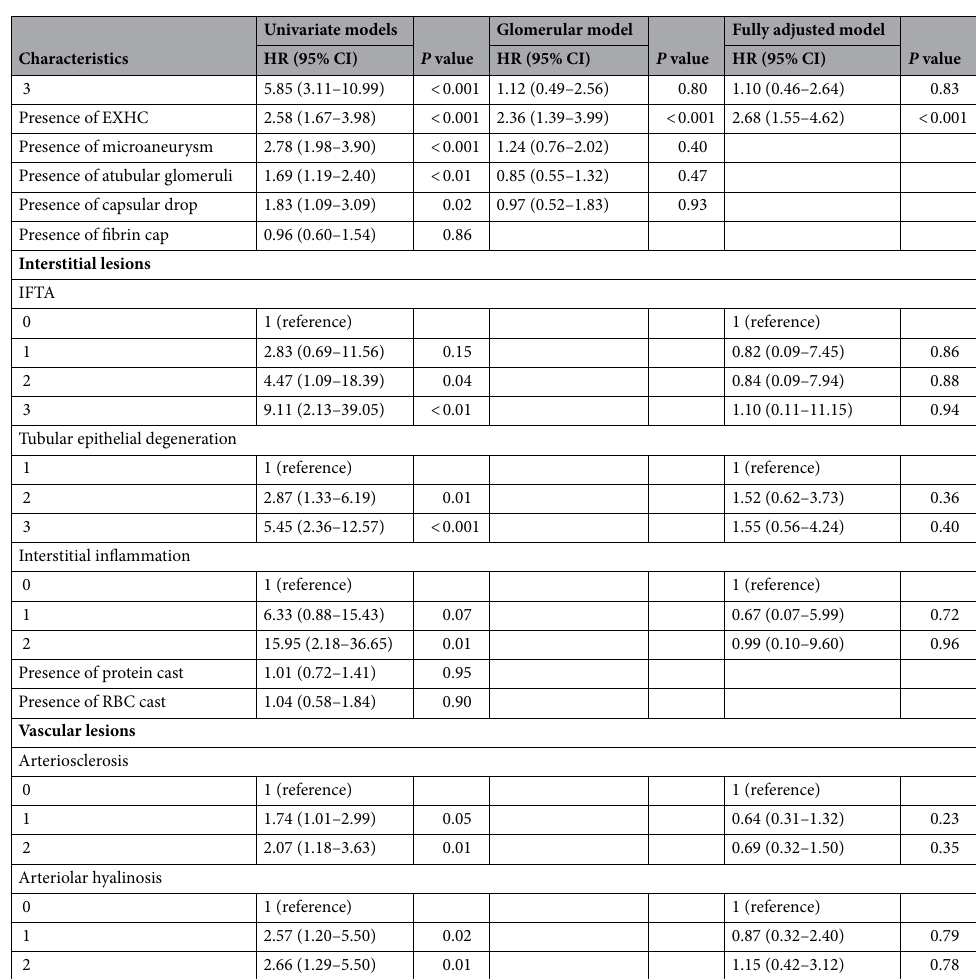
To verify the differences in protein expression between solidified glomerulosclerosis and KW lesions, immu- nohistochemical staining for complement C9 and ApoE was performed (Fig. 3). Glomeruli from class I samples with mild changes under light microscopy were used as diabetic controls. It was reported that focal segmental glomerular sclerosis (FSGS) displays a histological pattern characteristic of glomerular solidification, which represents the predominant pattern of glomerular obsolescence 15 . Therefore, solidified glomeruli in primary FSGS were used as nondiabetic controls. Immunohistochemistry showed that complement C9 and ApoE were highly expressed in both KW nodules and solidified glomerulosclerosis compared with class I glomeruli or pri- mary FSGS. Complement C9 was globally expressed among solidified glomeruli, and was localised in expanded mesangium and Bowman’s capsular membrane. ApoE was deposited in sclerosed areas of glomeruli or mesangial cell cytoplasm, or distributed in a granular pattern in the mesangial matrix (Fig. 3A). Moreover, consistent with the results of single glomerular proteomics, the percentage of the glomerular complement C9 and ApoE-positive area was higher in solidified glomerulosclerosis than in KW nodules (Fig. 3B,C).